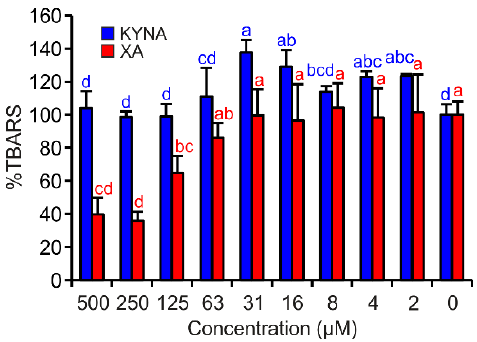
Figure 5. KYNA or XA effects on TBARS production in Fe II autoxidation assay. The bars are the means of three replications (± S.D.). Letters above the bars indicate significance levels (ANOVA with 95% Duncan’s post hoc test). TBARS: thiobarbituric acid reactive species, S.D.: standard deviation.